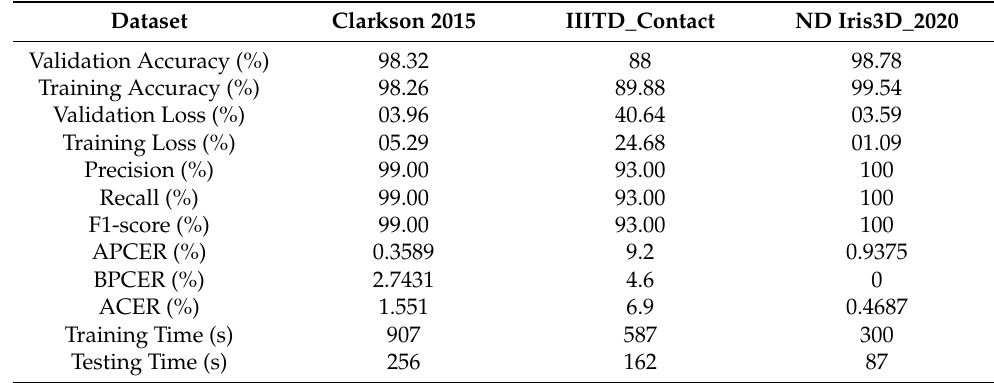
Table 7. Performance evaluation of the DenseNet121 model for iris liveness detection.